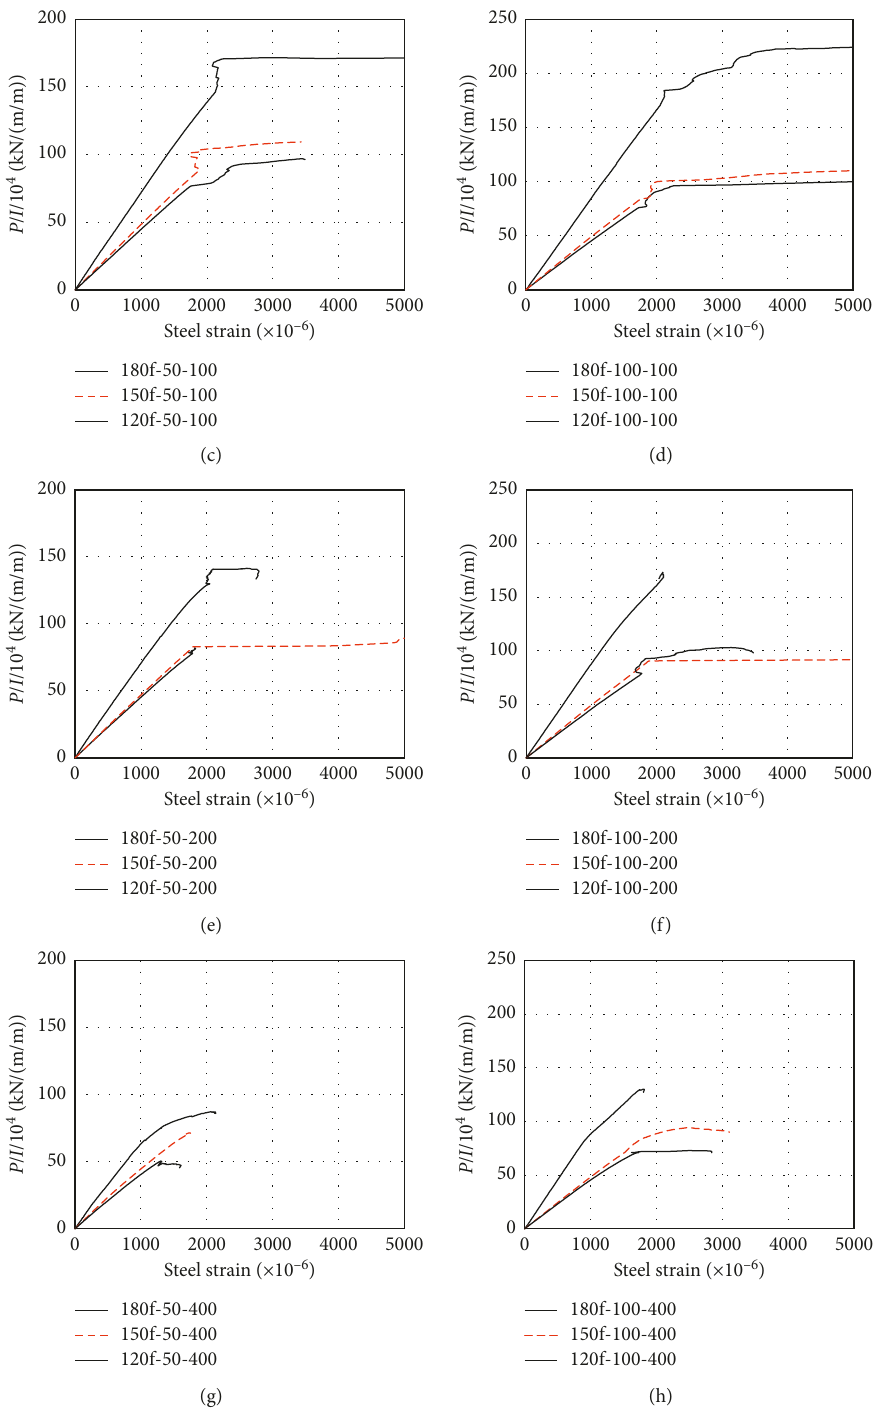
Figure 9: Load-strain curves at bottom flange of steel girder. (a) Slab thickness, stud spacing (50 mm, 50mm); (b) slab thickness, stud spacing (100mm, 50mm); (c) slab thickness, stud spacing (50mm, 100mm); (d) slab thickness, stud spacing (100mm, 100mm); (e) slab thickness, stud spacing (50mm, 200mm); (f) slab thickness, stud spacing (100mm, 200mm); (g) slab thickness, stud spacing (50 mm, 400mm); (h) slab thickness, stud spacing (50mm,